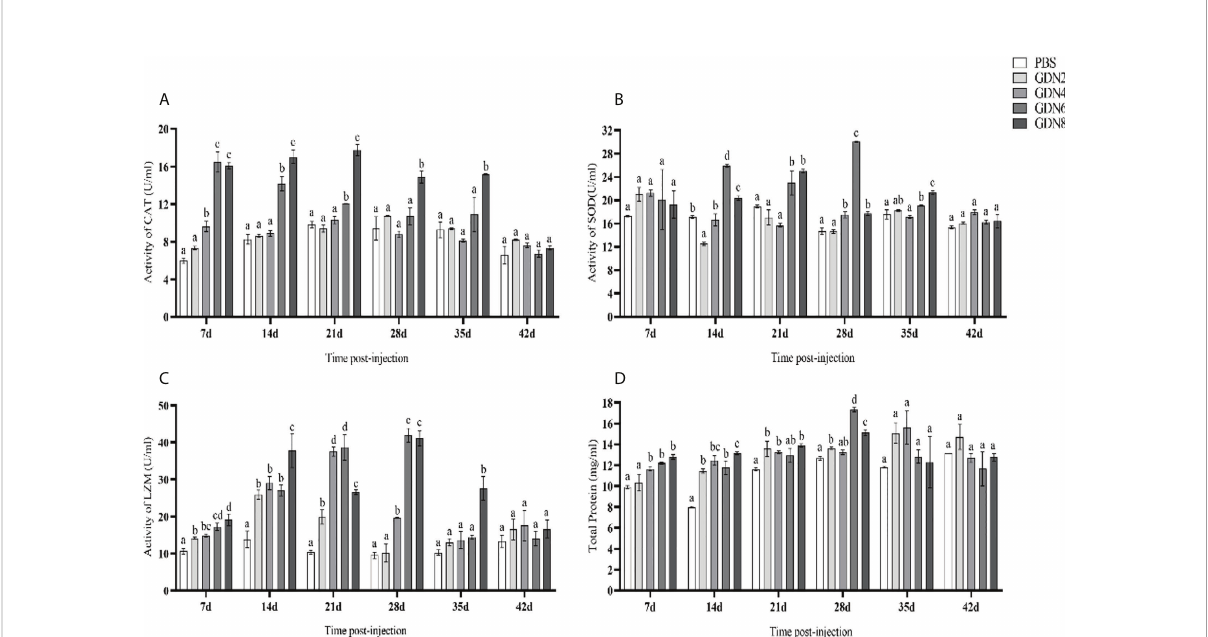
FIGURE 7 Catalase (CAT), superoxide dismutase (SOD), and lysozyme (LZM) activities and total serum protein of pearl gentian grouper at 7, 14, 21, 28, 35, and 42 days post-injection (mean ± SE; n = 3). (A) CAT activity, (B) SOD activity, (C) LZM activity, and (D) total serum protein. Signi fi cant differences ( p < 0.05) are marked by different letters (a –